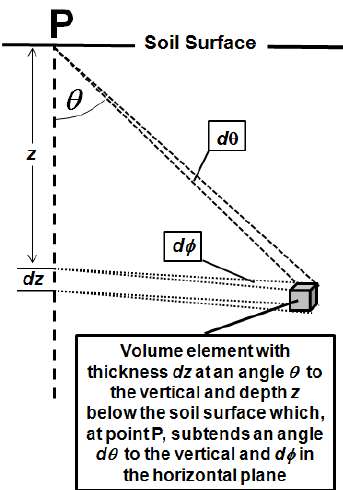
Fig. 2. The source volume element of fast neutrons created in the plane at depth z in the soil which may reach the measurement point P, but whose number is attenuated by an exponential factor with length constants L 3 and L 4 (in g per unit area), these being respectively determined by the chemistry of the soil and by the total water content of the soil, including lattice water.